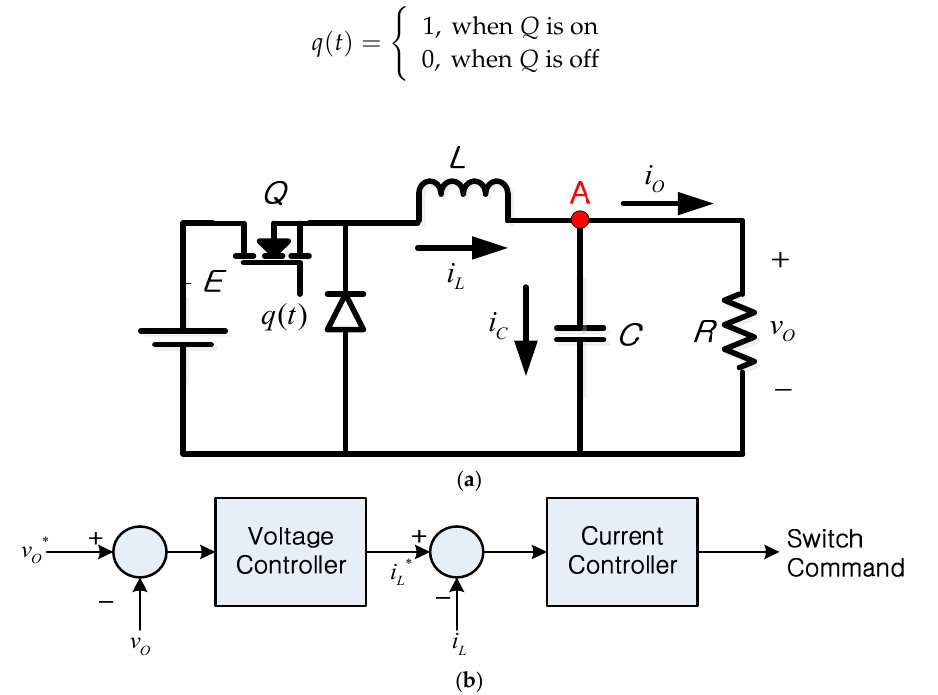
Figure 3. ( a ) Buck converter configuration; ( b ) control block diagram.